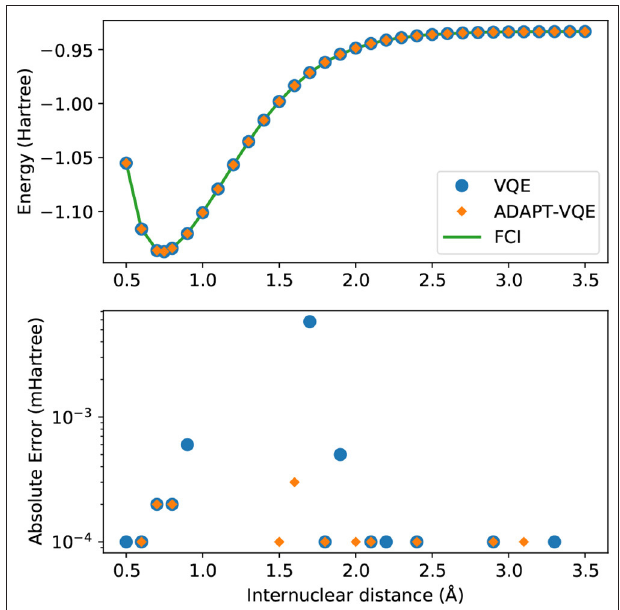
FIGURE 1 | (Top) Potential energy curves of H 2 computed with the STO-3G basis set for FCI (green solid line), VQE (blue circles), and ADAPT-VQE (orange diamonds) with the COBYLA optimizer. (Bottom) Absolute error in the minimized energy for VQE (blue) and ADAPT-VQE (orange) relative to the FCI reference